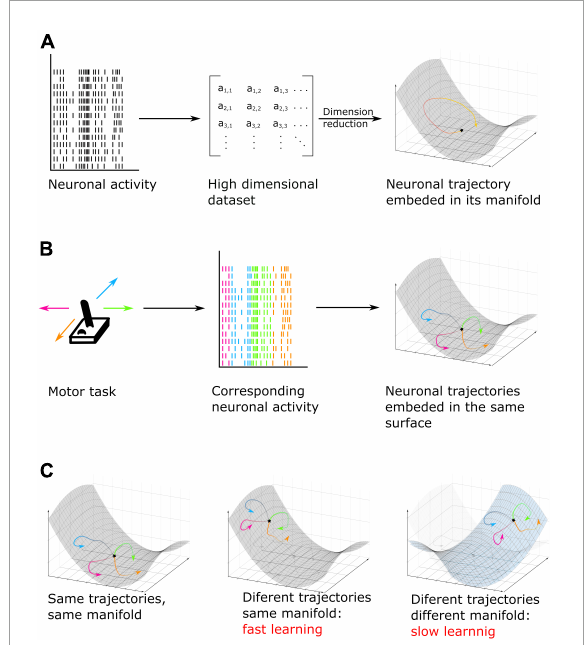
FIGURE5 (A) Neuronal activity, here MUA recordings, taken as an example, is converted into a lower dimensional space called manifold. In this low dimensional surface, the neural code can be represented as data points or trajectories when the pattern of activity is analyzed over successive time epochs. (B) Example of a motor task. Here, neuronal activity is recorded while subjects move a joystick in one of four possible directions. On individual trials, each movement can be represented by a different pattern of activity or trajectory but all trajectories are embedded in the same neuronal low dimensional manifold neural space [based on Gallego et al. (2017, 2018)]. (C) Example of cognitive training using manifold perturbation. Participants or animals are given a feedback (for example, cursor velocity) and have to learn to control it by using the same neuronal pattern as recorded during previous tasks (left) (for example, during a motor task). It is also possible to train subjects by using a different pattern embed in the original manifold (center) or in a new manifold surface (right). The last option leads to a slower learning and an increased difficulty of the task (based on Sadtler et al., 2014; Golub et al., 2018; Oby et al.,